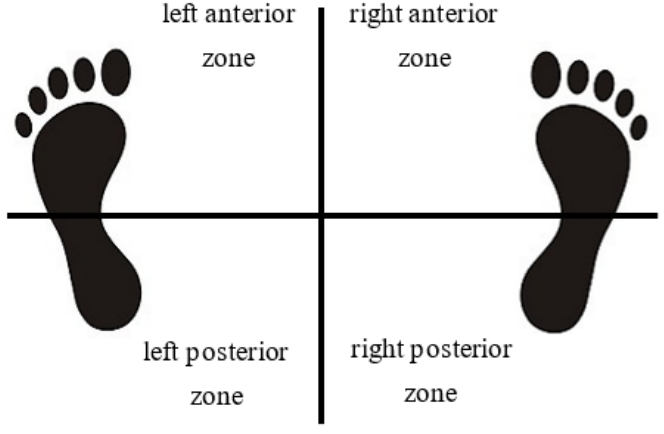
Figure 2. Zones of the plantar pressure distribution.